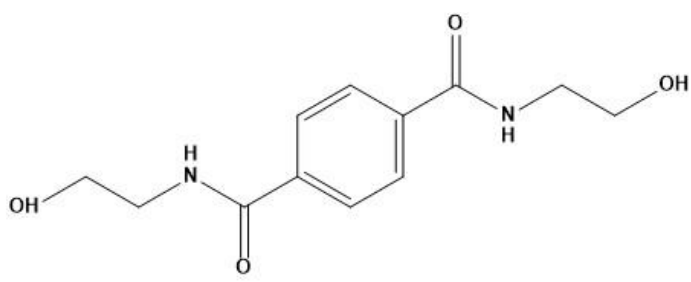
Figure 1. Chemical structure of N , N ′ -bis(2-hydroxyethyl) terephthalamide (BHET). Master batches of PLA containing 10% ( w / w ) talc or 5% ( w / w ) BHET were prepared using a Coperion twin-screw extruder equipped with gravimetrical dosing units. All materials were dried overnight at 60 °C in a vacuum before blending. Before spinning, the PLA granules were again dried overnight in a vacuum at 60 °C. The remaining moisture content was below 50 ppm, as determined by using a HydroTracer HT3 STD. Fiber samples were named according to the type and amount of nucleating agent (B = BHET, T =